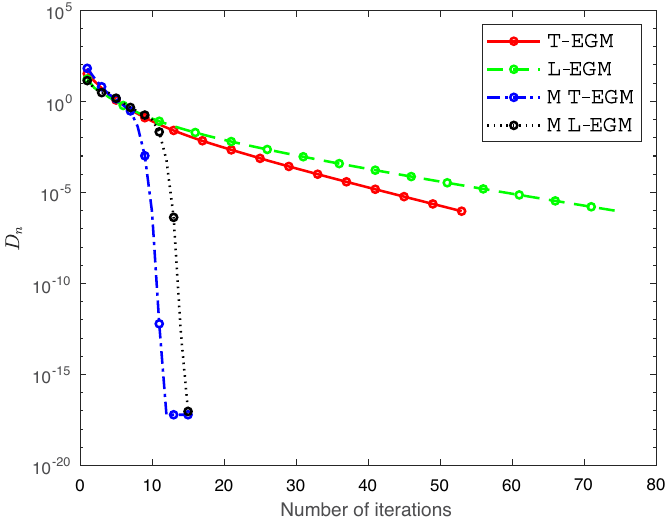
Figure 4: Numerical illustration of Algorithms 1 and 2 with Algorithm 1 in [ 28 ] and Algorithm 1 in [ 29 ] while N 200. =